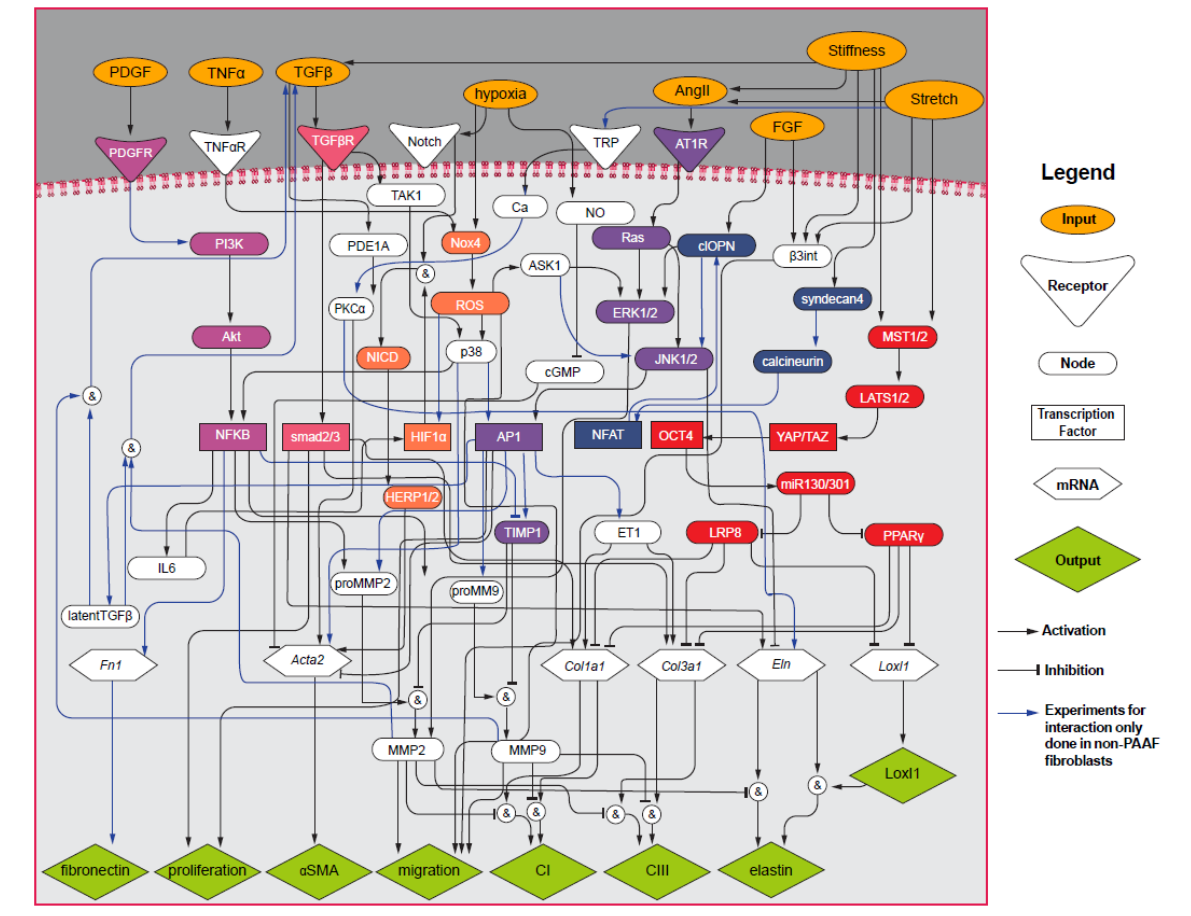
Figure 1. Pulmonary Arterial Adventitial Fibroblast (PAAF) mechanosignaling network with 8 input stimuli (orange ovals), 6 receptors (triangles), 34 nodes (ovals), 7 transcription factors (rectangles), 6 messenger RNAs (hexagons), and 8 phenotypic outputs (green diamonds), modified from our previous work [12]. Activation is shown with arrows and inhibition is shown with blunt head arrows. Blue arrows indicate non-PAAF-based experiments. Magenta nodes indicate the Phosphoinositide 3-kinase (PI3K) pathway, orange nodes indicate the Reactive Oxygen Species (ROS) pathway, purple nodes indicate the mitogen-activated protein kinase (MAPK) pathway, blue nodes indicate the calcineurin pathway, and red nodes indicate the Hippo signaling pathway.